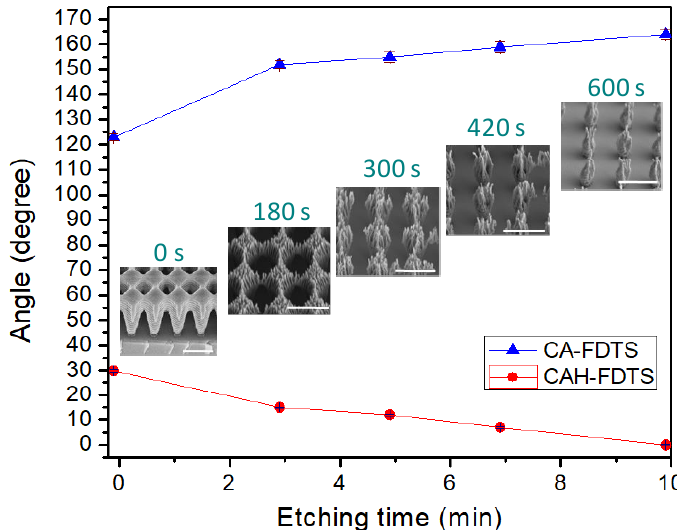
Figure 4. Water droplet CA and CAH measurement for FDTS-coated hierarchically-nanostructured surfaces with plasma etching time ranging from 0 to 10 min. The surface at 0 min refers to the NR-7 surface patterned with laser interference lithography but without oxygen plasma etching. The inserted images are the SEM images of the nanostructures obtained with the different etching times before the coating of FDTS. The scale bar in each inset represents 1 µm.